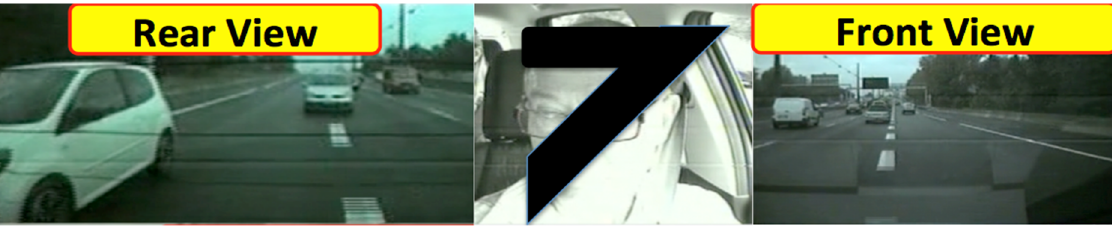
Figure 4. Typical example of driving error during a lane change (on the right ) on highway.